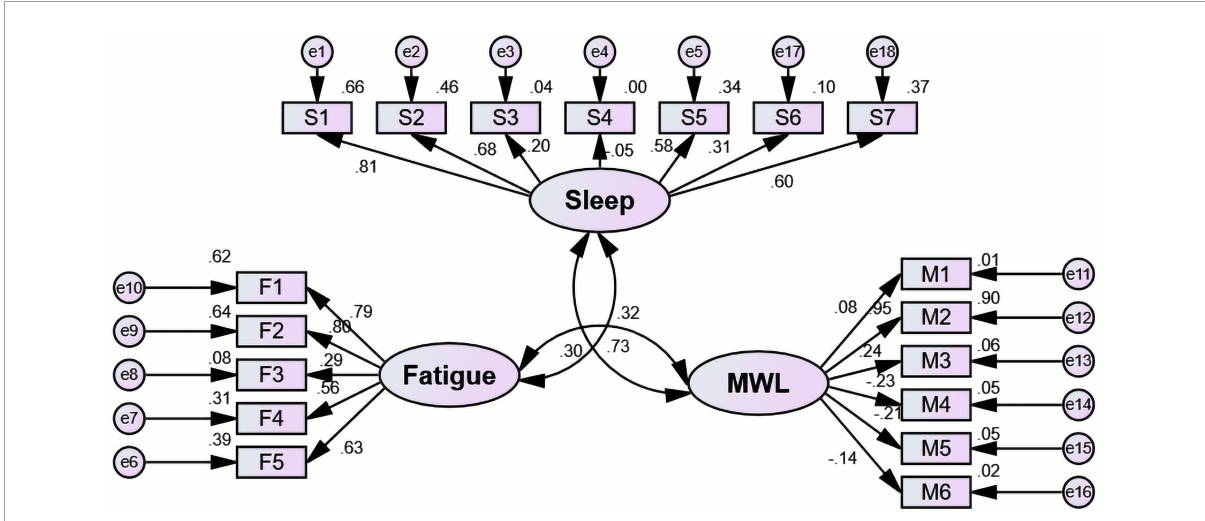
FIGURE3 Model of the correlation among sleep, fatigue and mental workload in frontline nurses ( n = 1004). MWL, mental workload; S1, sleep quality; S2, sleep latency; S3, sleep duration; S4, sleep efficiency; S5, sleep disturbance; S6, hypnotic drug; S7, daytime dysfunction; M1, mental demand; M2, physical demand; M3, temporal demand; M4, performance; M5, effort; M6, frustration level; F1, comprehensive fatigue; F2, physical fatigue; F3, activity reduction; F4, motivation decline; F5, mental fatigue.